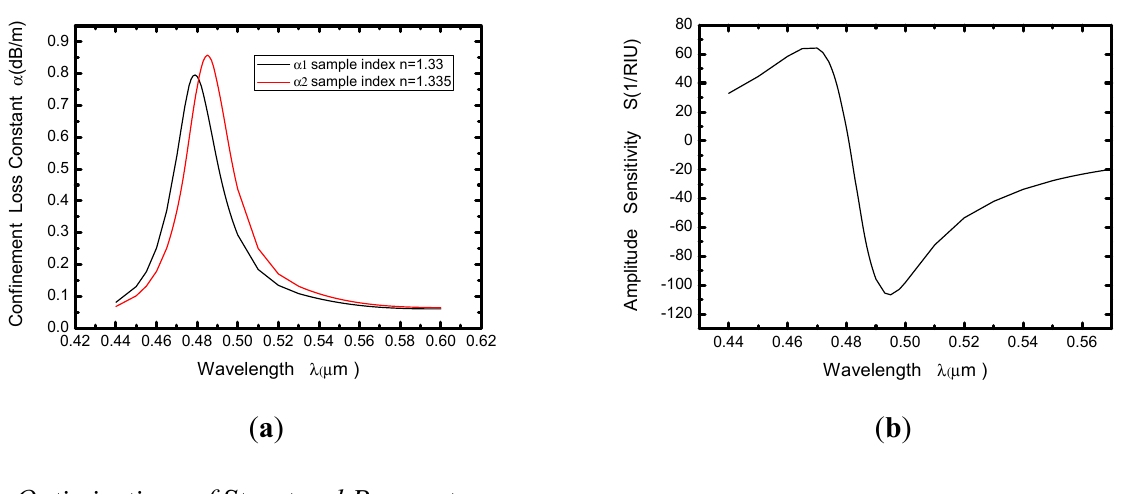
Figure 6. ( a ) Relationship between wavelength and attenuation constant of the fundamental mode of the PMMA PCF. The black and red curves represent the refractive indices of the samples are 1.33 and 1.335 ( Δ λ detection sensitivity curve.